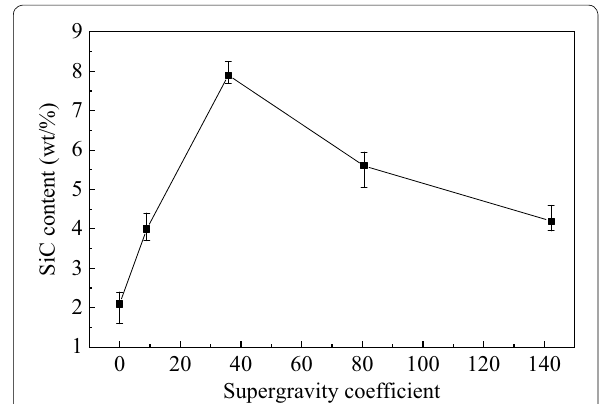
Figure 3 SiC content in Ni-Co/Si coatings under different supergravity